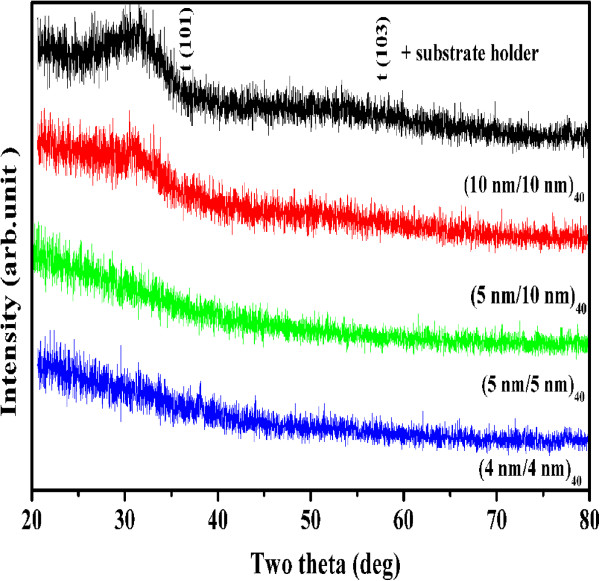
XRD pattern of the Al2O3/ZrO2nanolaminates with 40 bilayers deposited on Si (100) at 300 K.